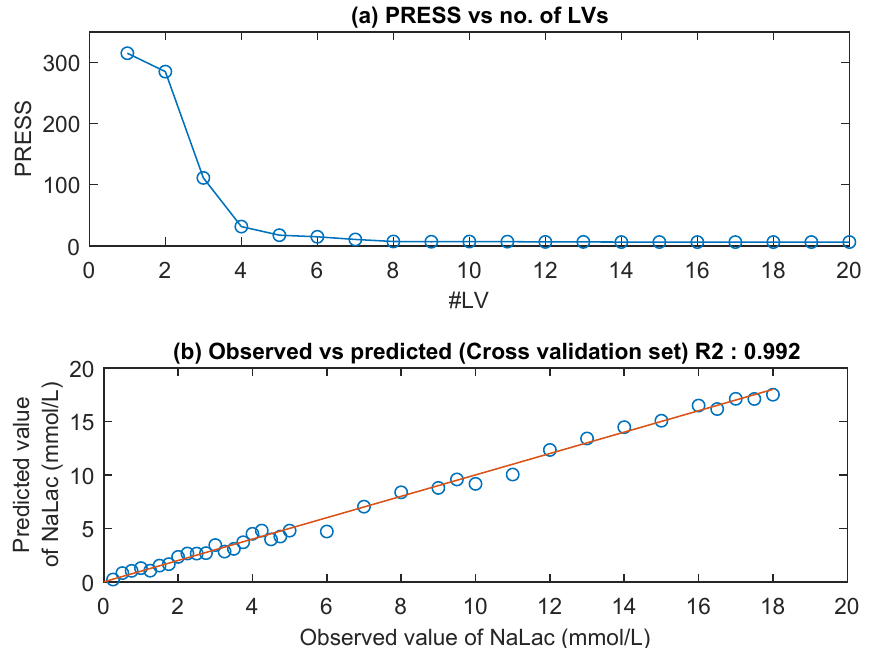
Figure 8. ( a ) PRESS value for the PLS algorithm, optimal no. of LVs used: 8. ( b ) Relationship between the predicted NaLac concentration and the reference NaLac concentration of thirty-seven PBS samples. The correlation coefficient (R 2 ) and root mean square error of cross-validation (RMSECV) were 0.992 and 0.49 mmol/L